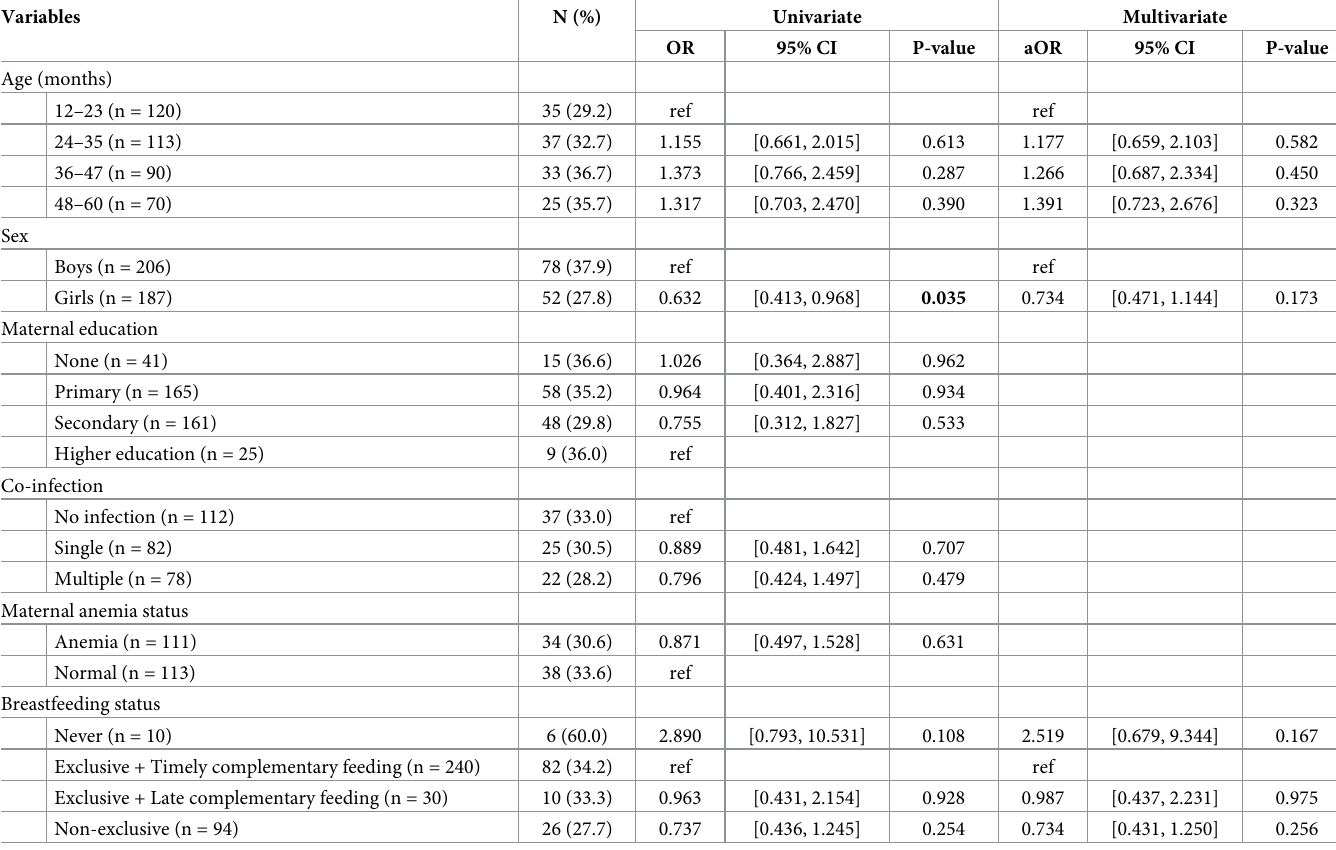
Table 4. Factors associated with weight-for-age Z-score (WAZ) among preschool-age children (PSC) in this study (n =